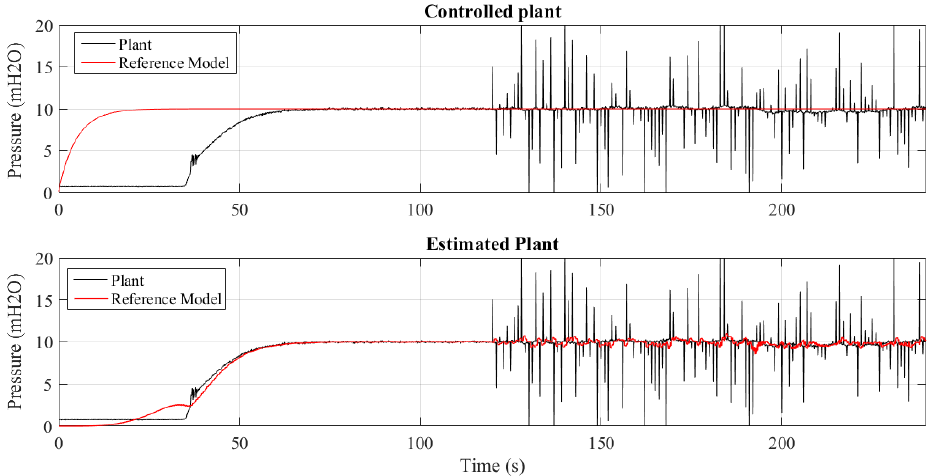
Figure 14. System controlled using MCC criterion subjected to outliers every 1